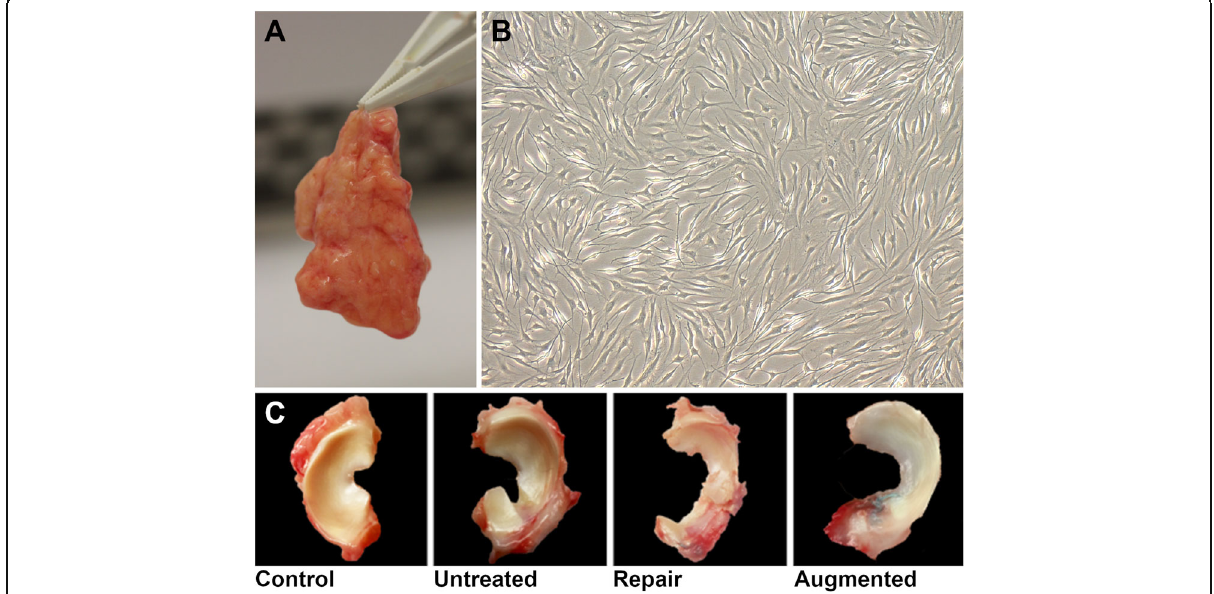
Fig. 5 Augmented meniscal repair in a goat model. a) Isolated infrapatellar fat pad (IPFP) b) IPFP-derived mesenchymal stromal cells under microscope demonstrating characteristic spindle-shaped morphology c) Goat meniscus 6 months after creation of a critical-sized radial meniscal tear in 4 different groups: Control, no meniscal tear; Untreated, radial meniscal tear left in situ; Repair, radial tear repair with single horizontal mattress suture; Augmented, radial tear repair with single horizontal mattress suture + augmentation with cell-seeded hydrogel at the tear site. Suture repair minimized gap formation and neotissue formation was further improved with cell-based